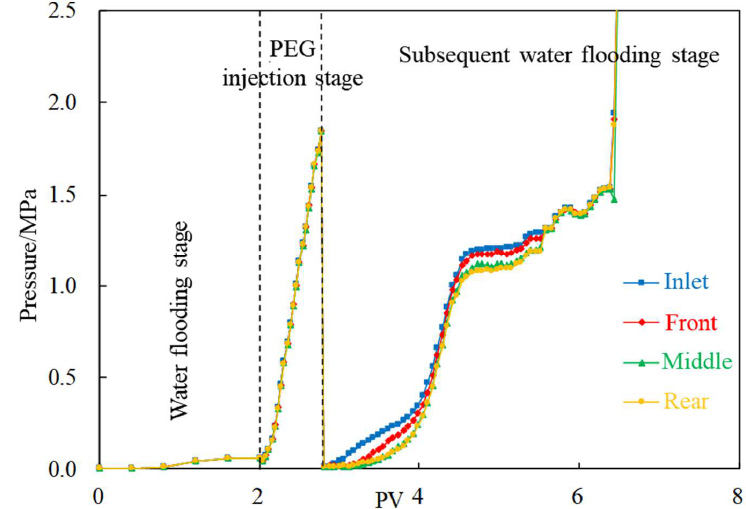
Figure 8. Pressure change curve (injection rate is 0.3 mL/min).